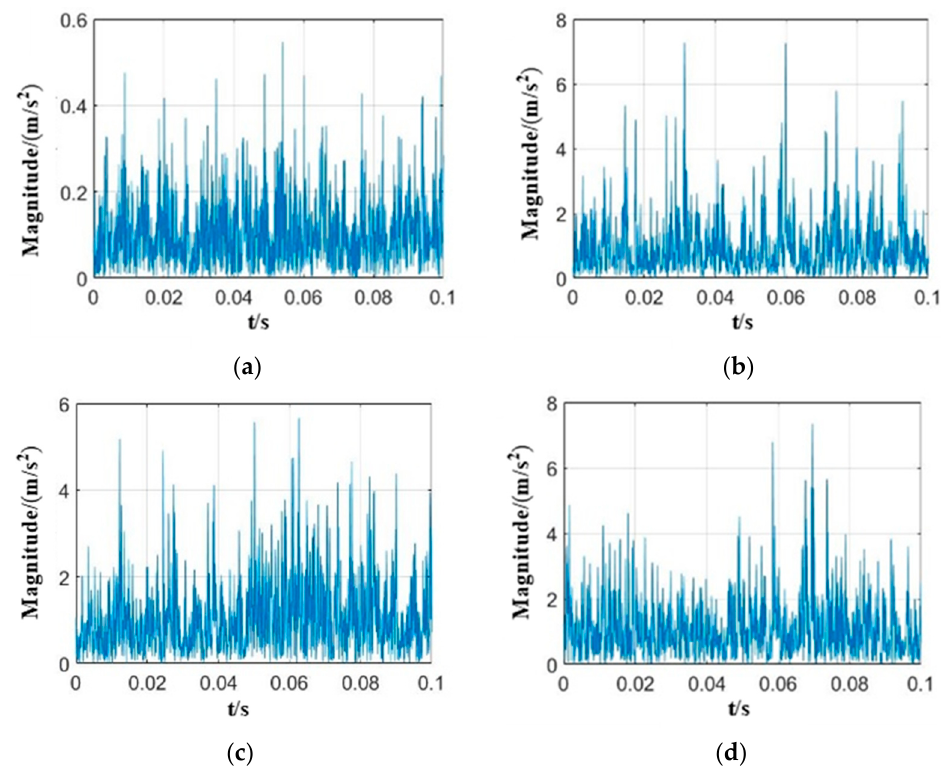
Figure 5. Time domain waveform of pump volute tongue. ( a ) normal operation. ( b ) incipient cavitation. ( c ) cavitation. ( d ) severe cavitation.